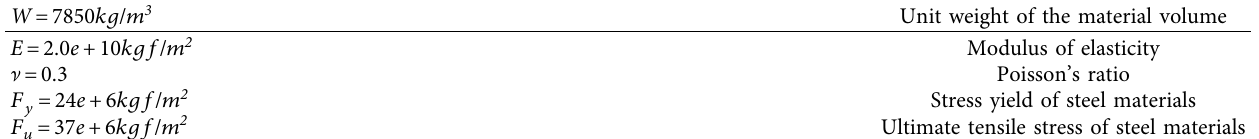
Table 2: Specifications of the steel materials.